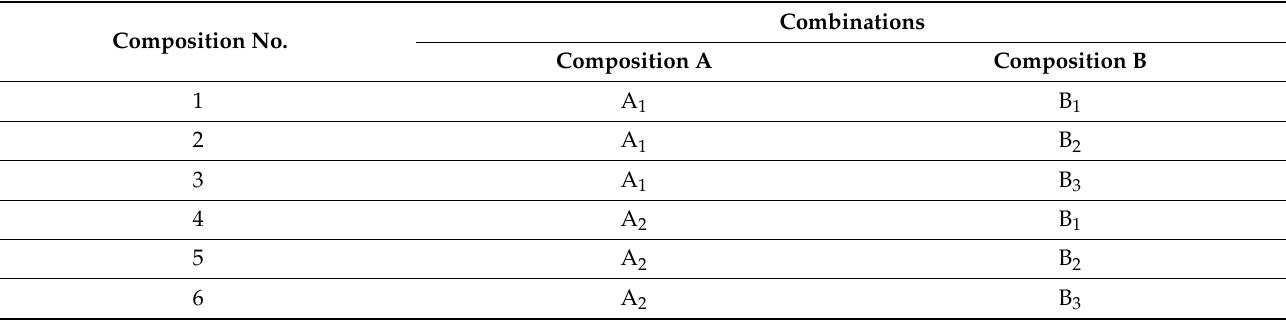
Table 4. Oil components of the epoxy waterproof adhesive layer.